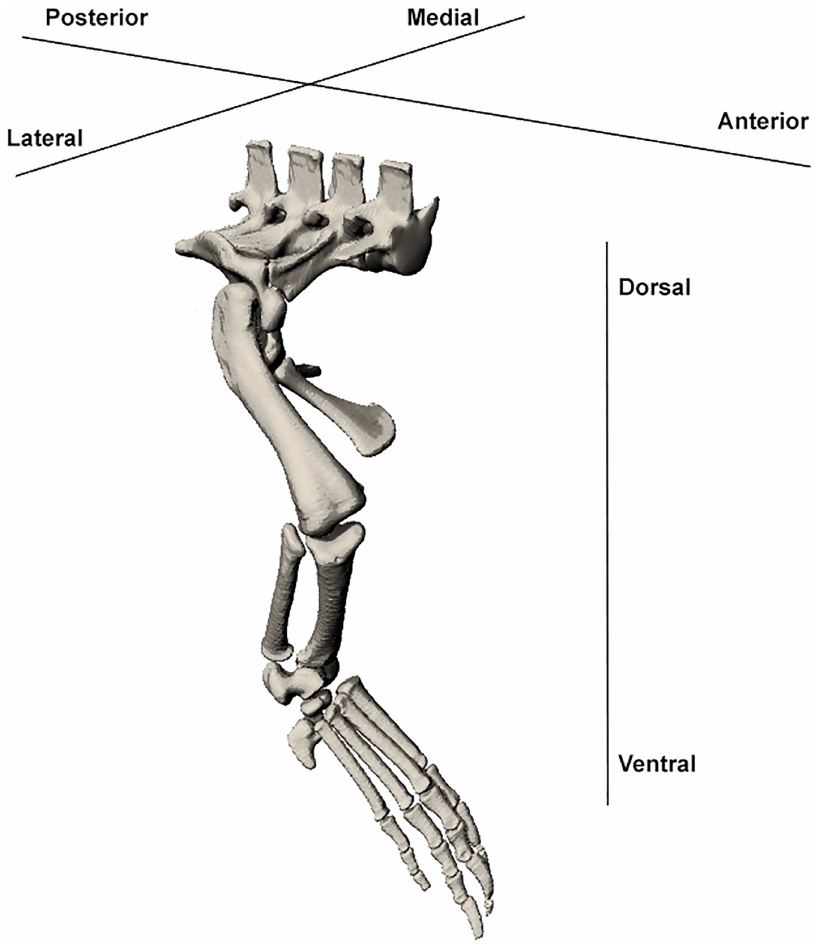
Fig 2. Orientation terminology used in muscle description. Diagramof the Crocodylusporosus hindlimb with terms used to describeorientation.